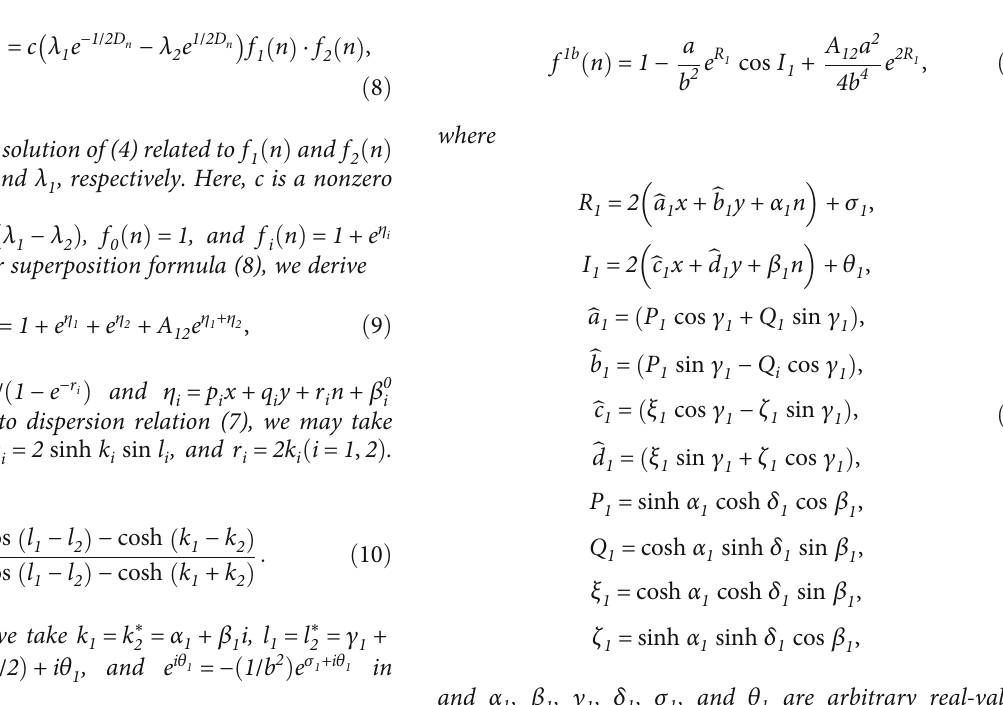
Figure 3: Propagation of hybrid solution composed of two line solitons and one breather at di ff erent times: (a) n = − 40 , (b) n = 0 , and (c) n = 40